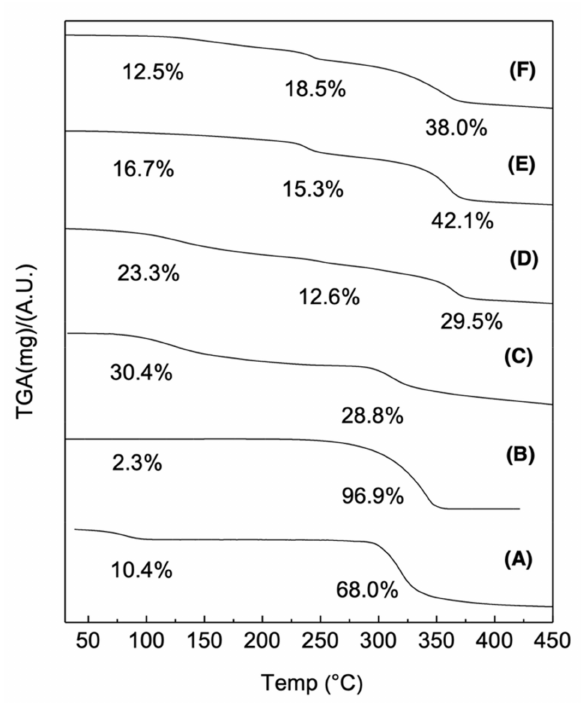
Figure 5. TGA thermograms of ( A ) α -CD, ( B ) ODA, ( C ) ODA-PHA, ( D ) α -CD/ODA-PHA, ( E ) β -CD/ODA-PHA, and ( F ) γ